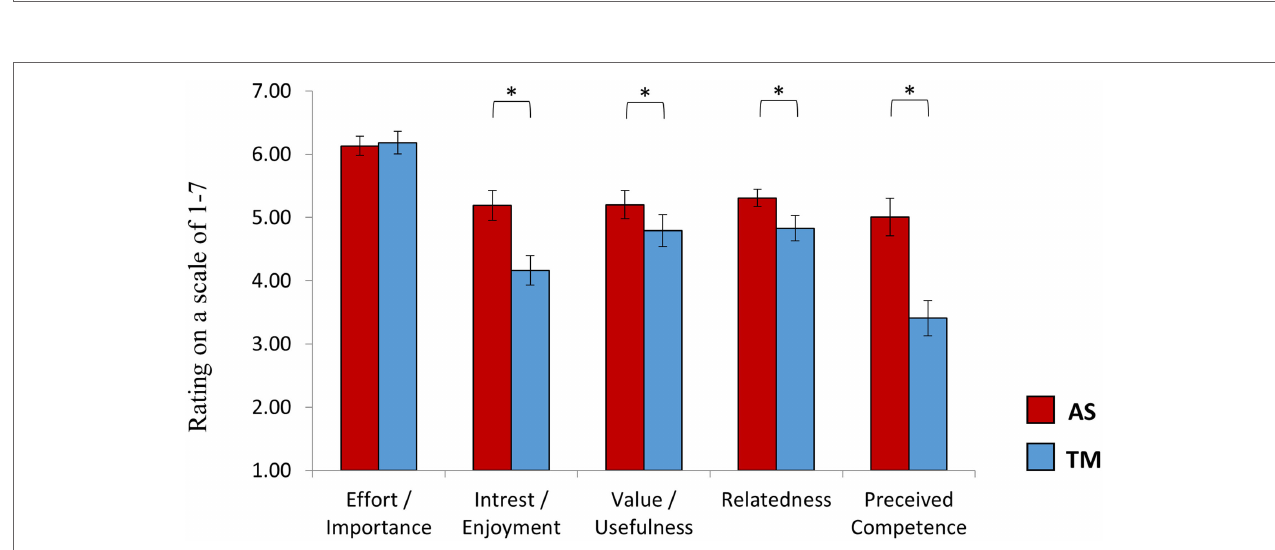
FigUre 5 | Transfer testing at session 2 . (a) When introduced to an unfamiliar context (skateboard interface) although both groups were able to downregulate the amyg-EFP during NF relative to rest, the AS group showed an overall lower amyg-EFP signal amplitude. (B) Similar to the first transfer trial, the AS group showed an overall lower amyg-EFP activity relative to the TM group. The condition effect (NF < rest) was significant only for the AS group. * p < 0.05, ** p < 0 01, *** p <